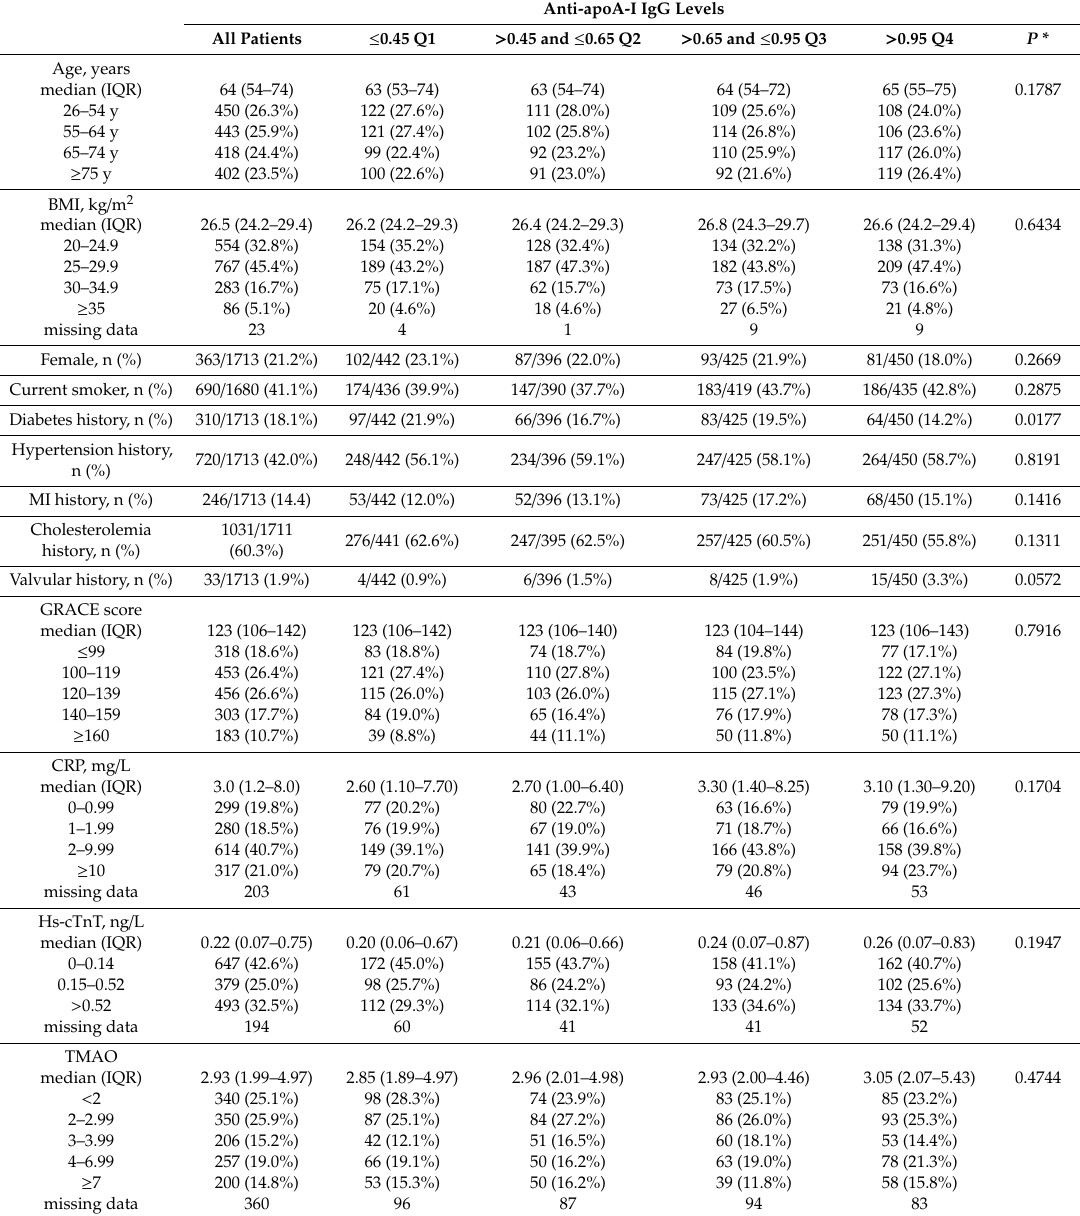
Table 5. Exploring the factors associated with autoantibodies against apolipoprotein A-I (anti-apoA-I IgG)